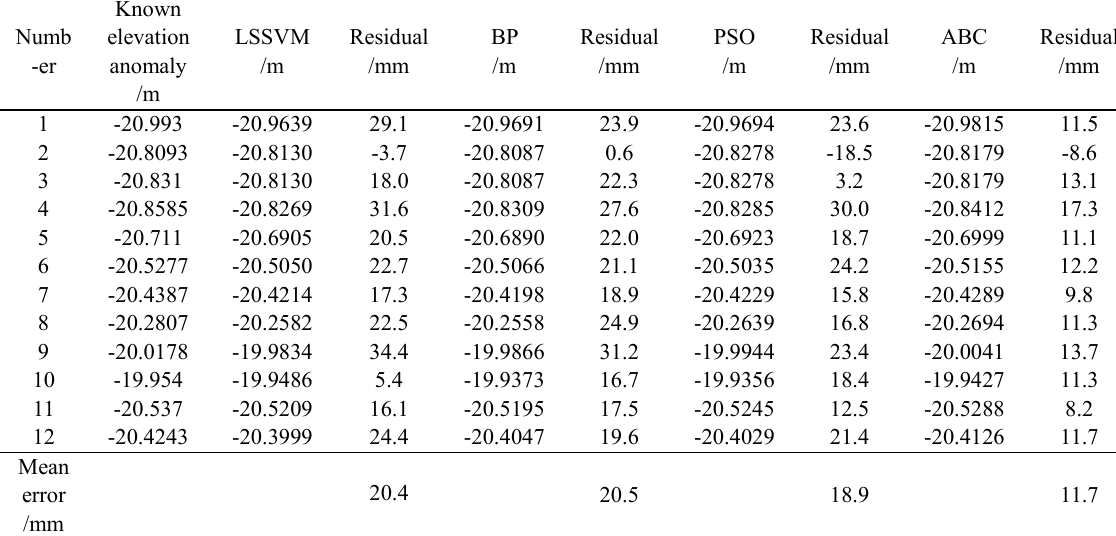
Table 2. Comparison of fitted residuals of detection points Comparison of fitting residuals of detection